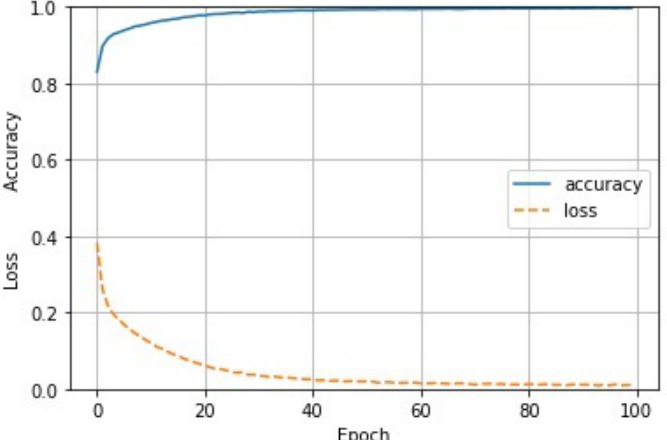
Figure 6. Accuracy and loss during the training of our model.